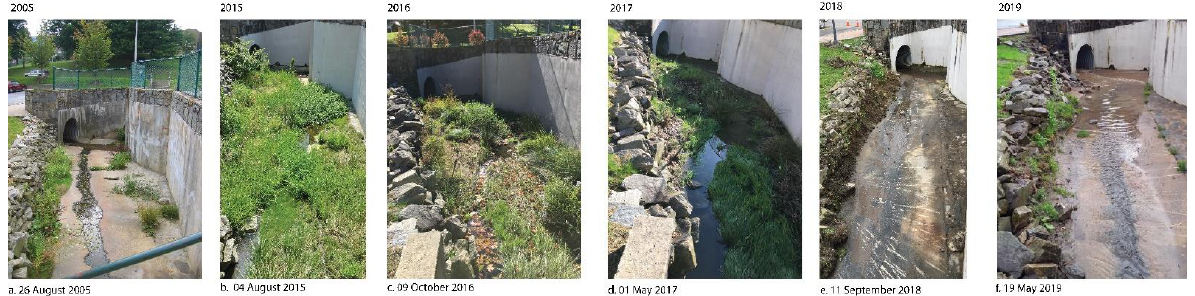
Figure 4. Evolution of the Accidental Wetland (AW) from 2005–2019. The photos were taken on the bridge over the wetland, facing downstream toward Boone Creek. The wetland was removed in September of 2018.